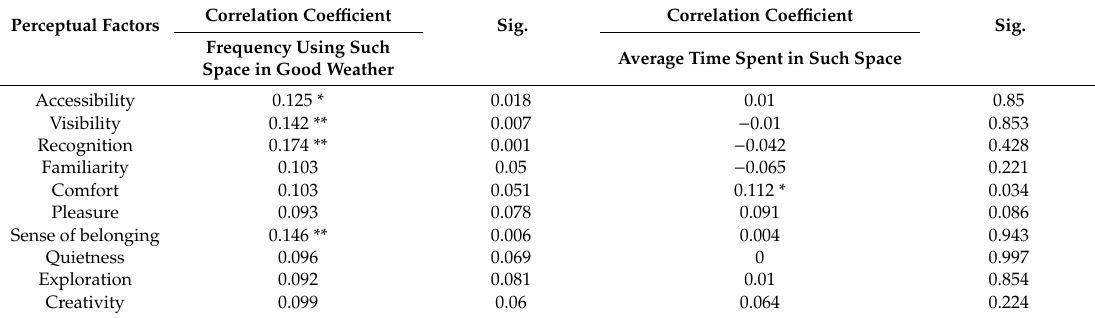
Table 3. Correlation between perceptual factors and user preference of attention restoration space (n = 360).